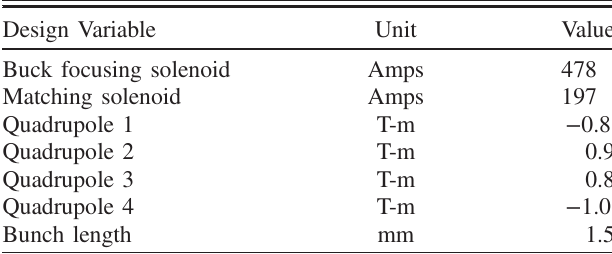
TABLE IV. Input parameters for the optimized solution shown in Figs. 9 and